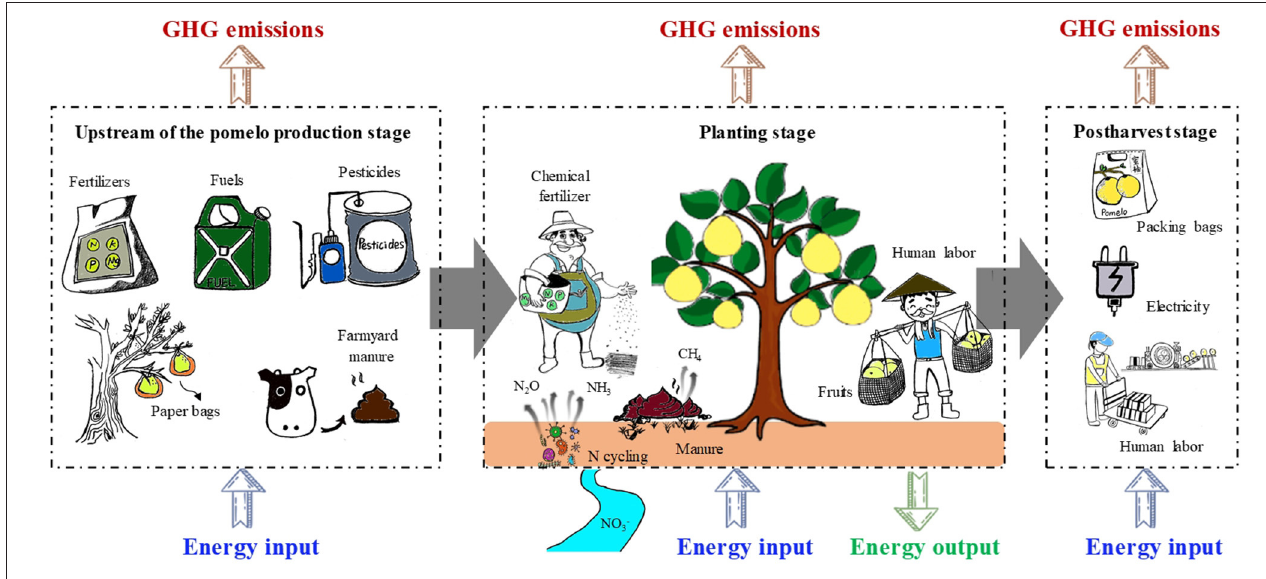
FIGURE 3 | The system boundaries of pomelo